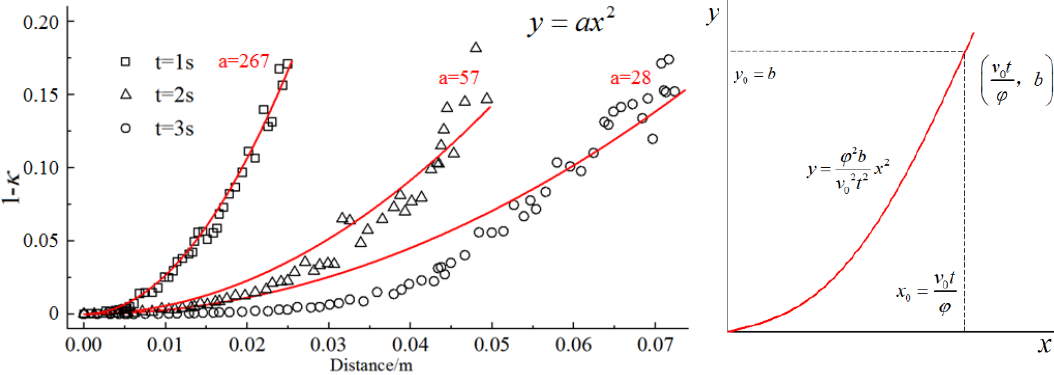
Figure 4. Regression analysis on the filling degrees.